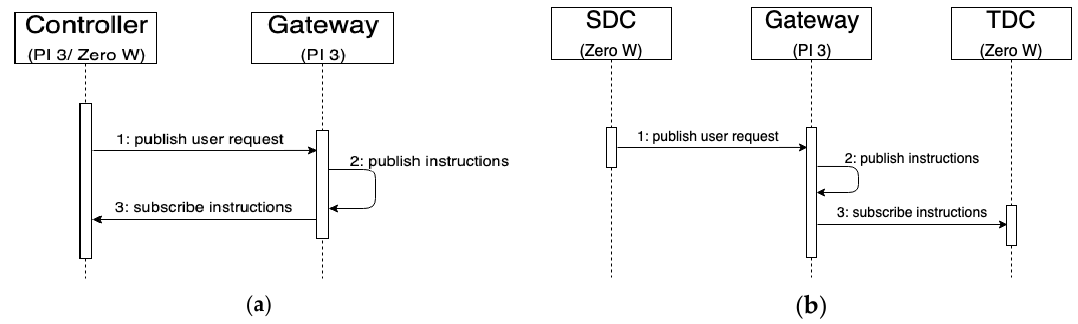
Figure 10. Time sequence diagram of publish/subscribe between ( a ) same devices and ( b ) different devices.